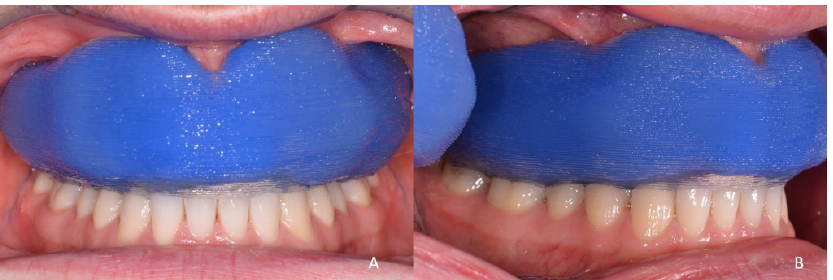
Figure 8. The Drop-on-Demand printed multi-material MG in situ, showing a good adaptation to the soft tissue and lower dental arch from the frontal ( A ) and side aspects ( B ). The staircase effect leaves a macro roughness which is expected to harm the soft tissue over a short wearing period and therefore should be further post-processed.